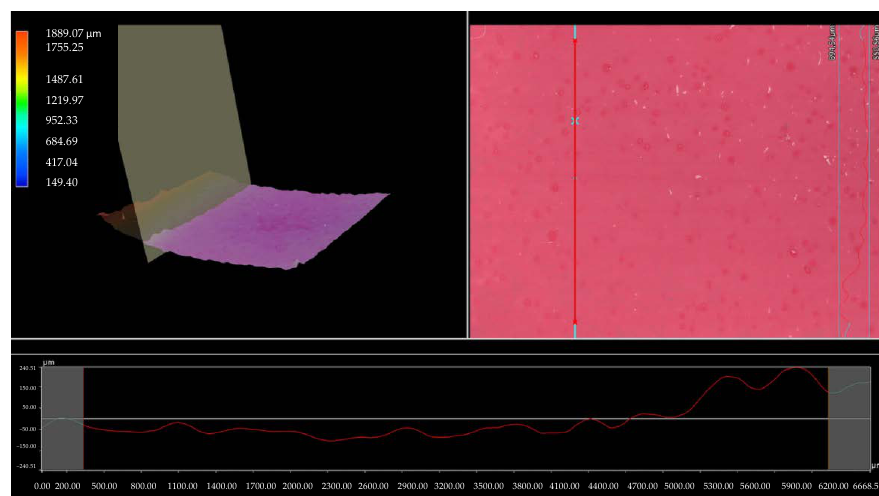
Figure 5. 3D view and the roughness profile (along the red line) of sample 575/12.5.